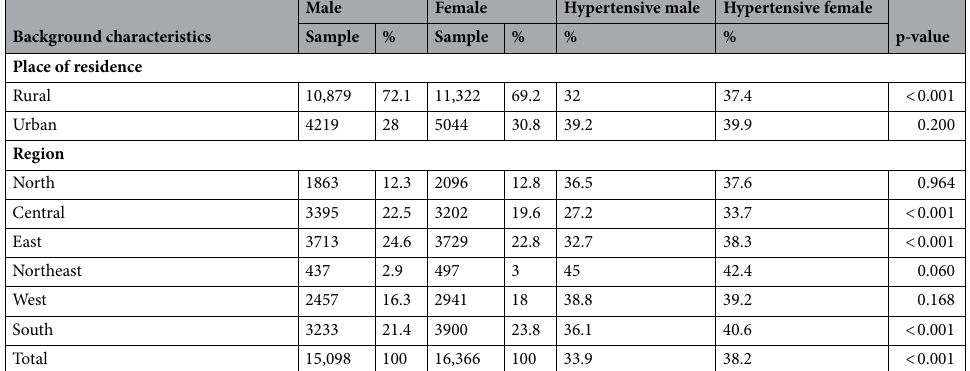
Table 1. Sample characteristics and prevalence of hypertension among older males and females in India, 2017–18. a The sample may differ as all older adults did not give consent for the measurements; Difference =